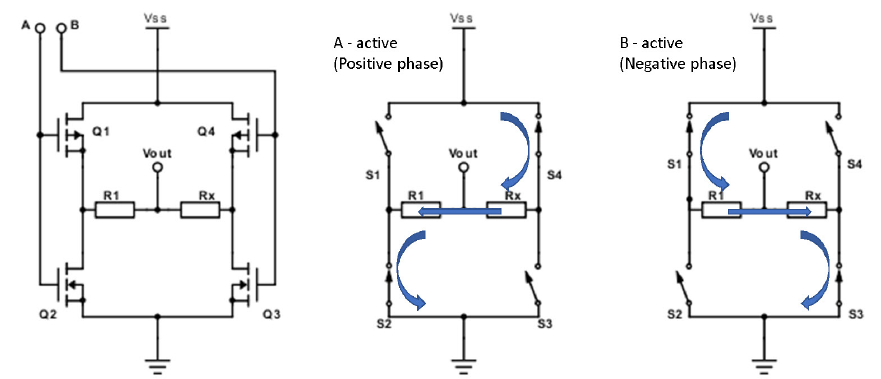
Figure 7. The H bridge for the EC sensor schematic ( left ); the blue arrow denotes current flow in positive phase (bridge MOSFETs approximated with switches) ( middle ); and the blue arrow denotes current flow in negative phase ( right